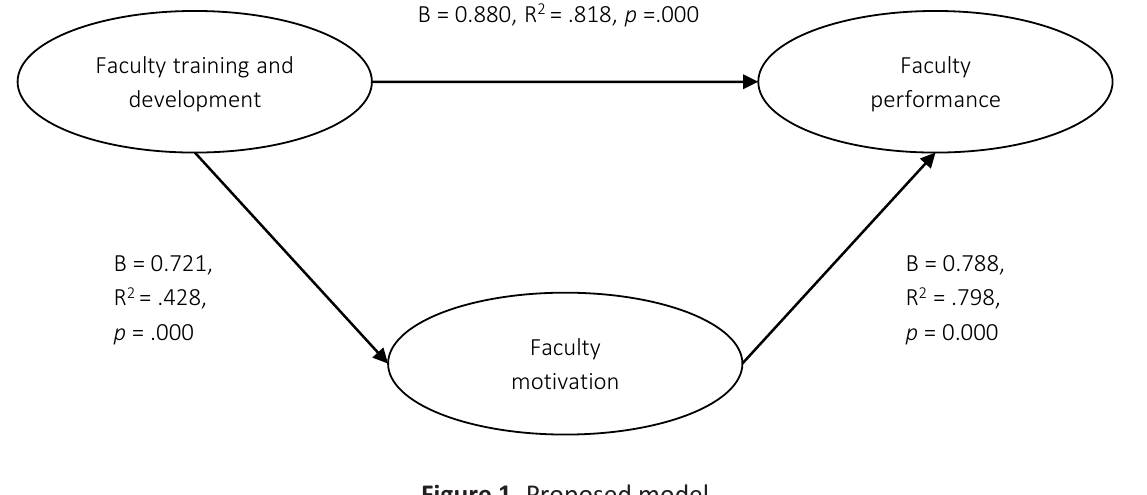
Figure 1. Proposed